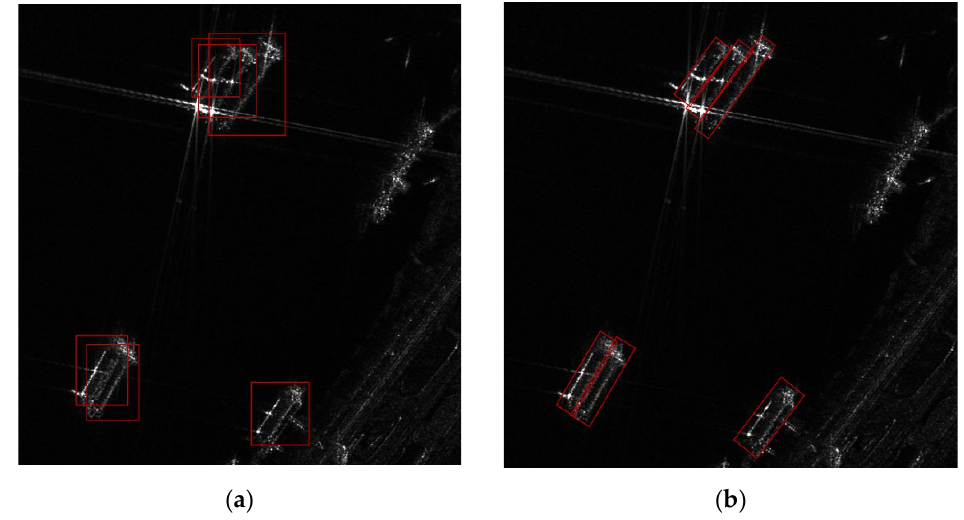
Figure 2. Comparison of the horizontal box and the rotatable box: ( a ) horizontal box; ( b ) rotatable